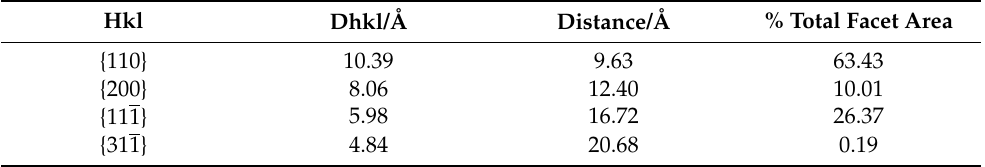
Figure 4. Crystal morphology of MIL-121 predicted by BFDH module. Table 1. Crystal surface parameters of